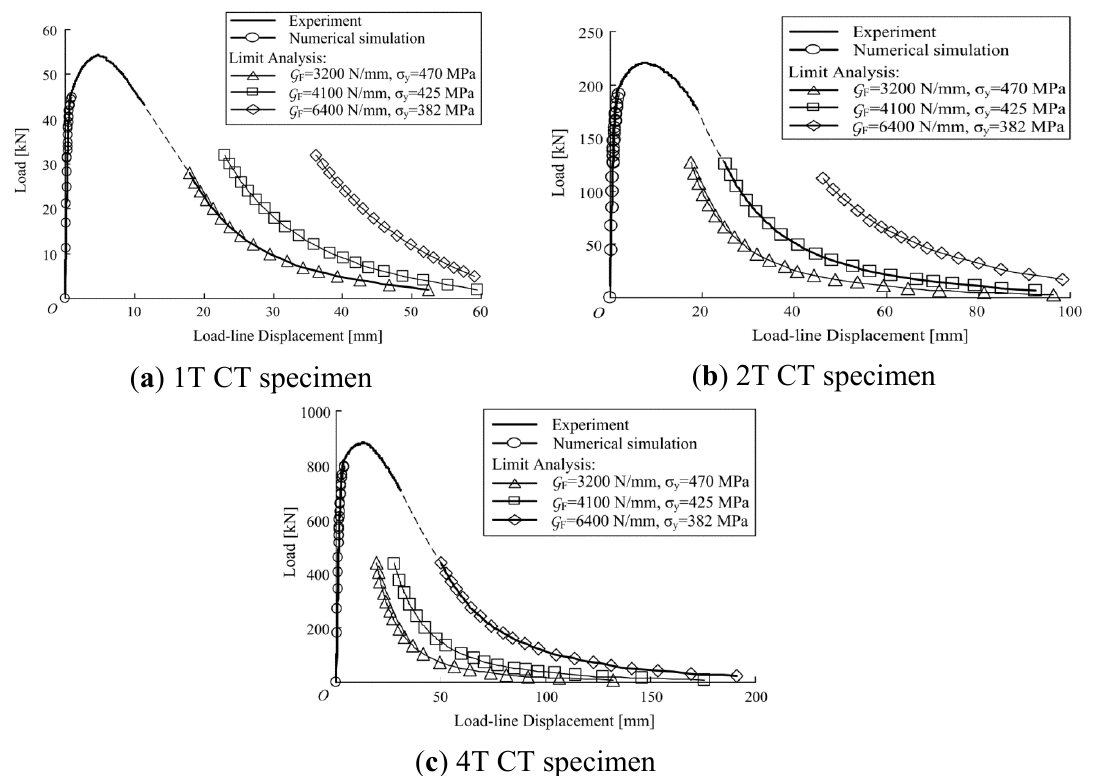
Figure 13. Comparison between experimental results [17], numerical simulations and limit analysis predictions for 1T, 2T and 4T CT specimens.